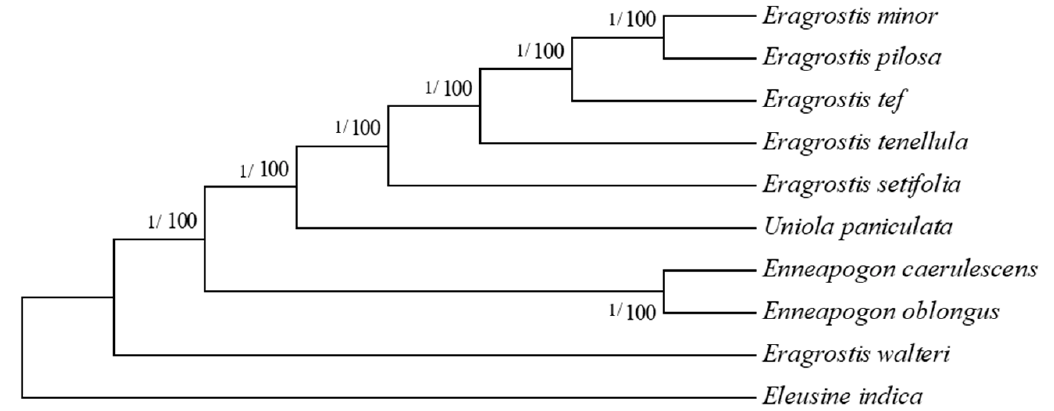
Figure 6. The K2P values for individual protein coding genes.